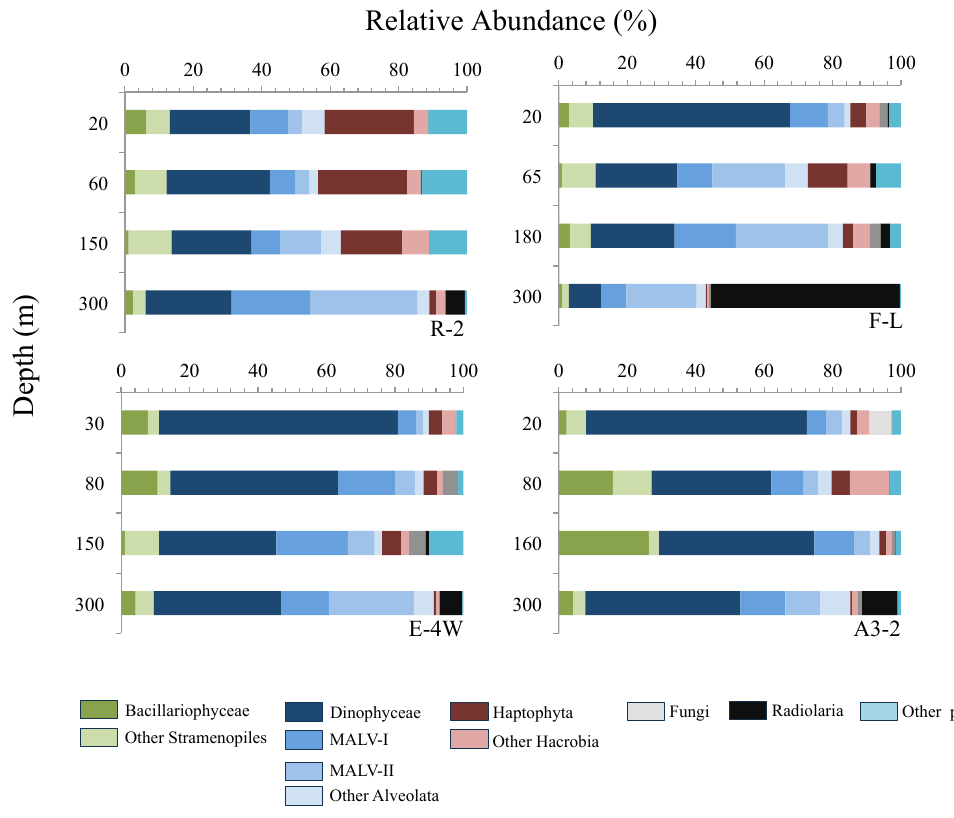
Figure 4. Relative abundance of major high-level taxonomic groups at each station and